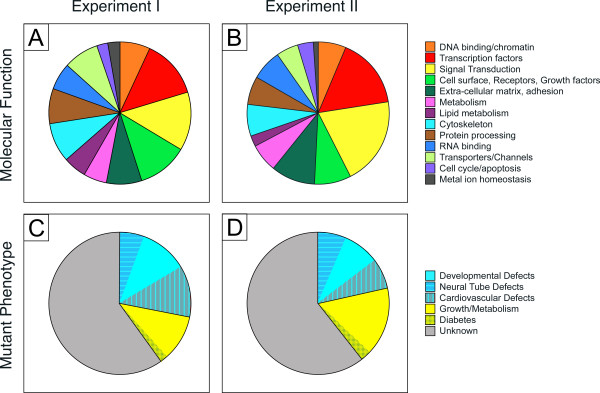
Expression of Hif1α during mouse embryogenesis. Quantitative RT-PCR for Hif1α at various stages of development normalized to expression levels of Pole4. n = number of individual embryos tested.